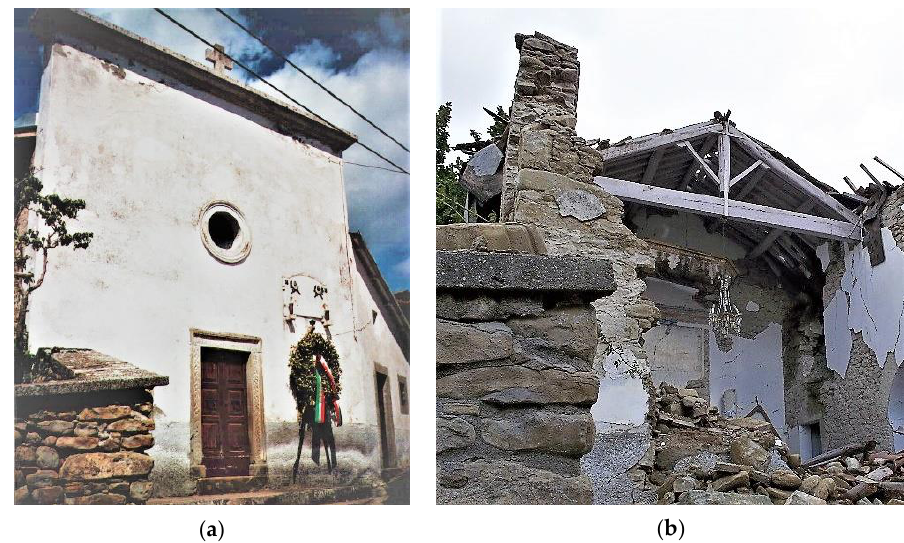
Figure 11. The St. Francis church in Cornillo Vecchio (Amatrice): ( a ) before and ( b ) after the earthquake occurred on 24 August 2016.